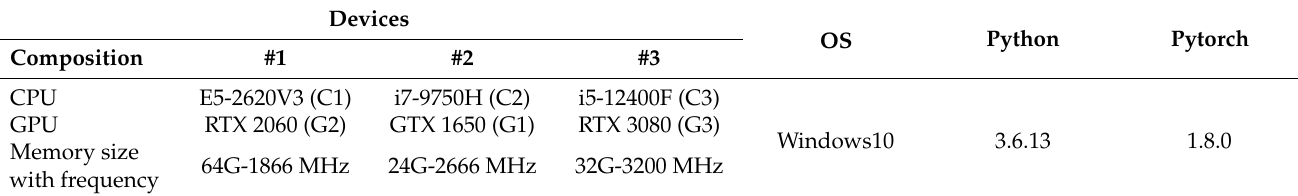
Table 1. Hardware usage and algorithm operation platform.